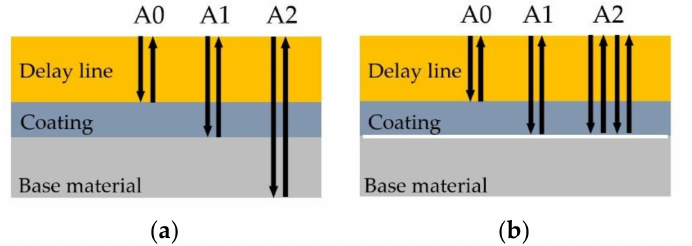
Figure 1. Schematics of the waveform path: ( a ) perfectly bonded and ( b ) debonded case between the coating and base